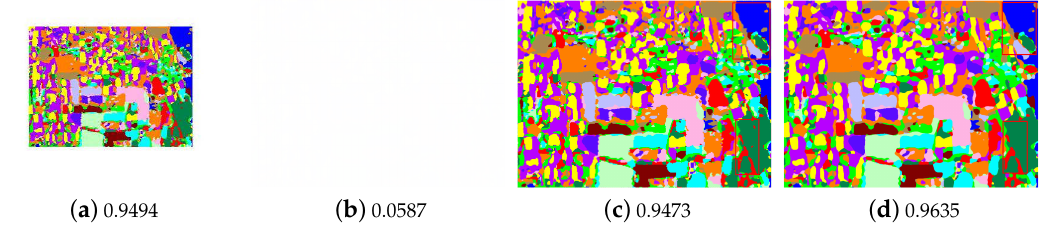
Figure 8. Classification result and accuracy values of PolSAR database Flevoland from NASA/JPL AIRSAR: ( a ) result with 1 down-sampling rate, ( b ) result and accuracy value with zeroth-order 16 information, ( c ) result and accuracy value without Laplace prior, and ( d ) result and accuracy value with entire-structure